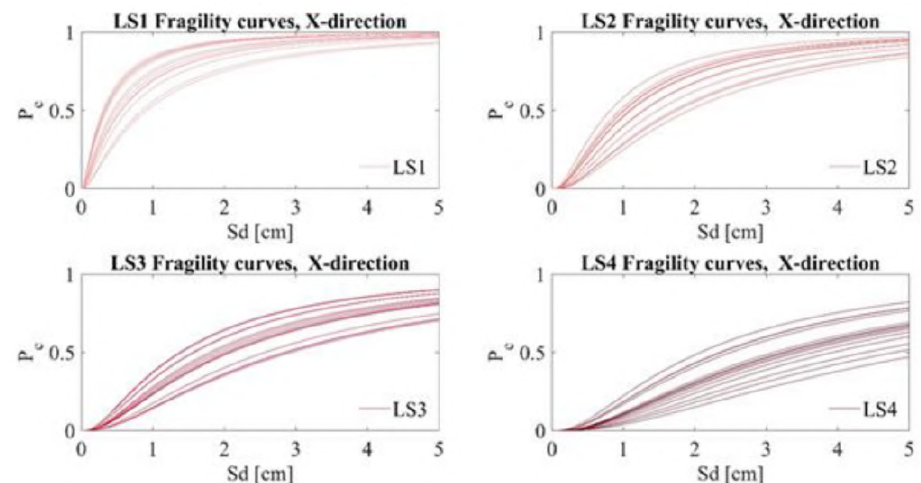
Figure 14. Fragility curves for the four limit states of interest, for the X-direction.